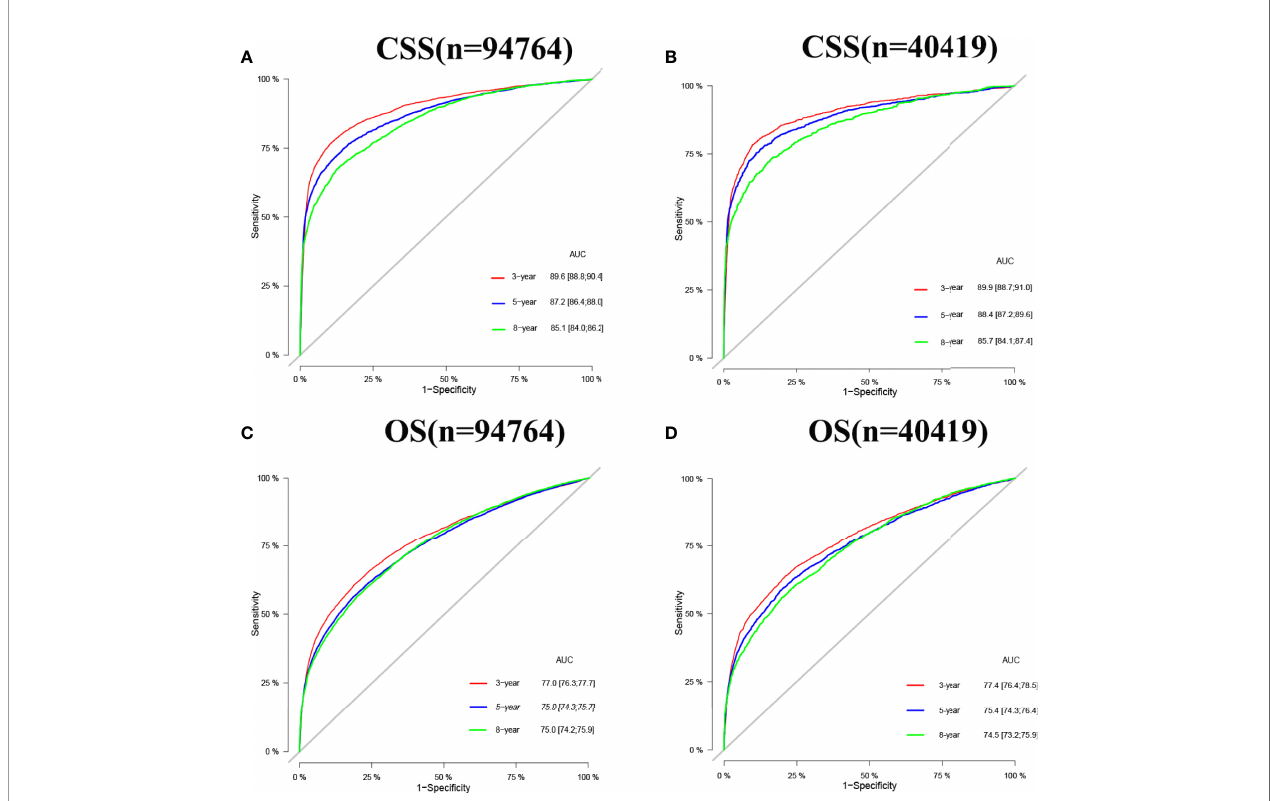
FIGURE 4 | AUC for predicting 3-, 5-, and 8-year CSS and OS in elderly patients with PC. (A) The AUC at 3-, 5-, and 8-year for CSS in the training set was 89.6,87.2, and 85.1. (B) The AUC for CSS in the validation set was 89.9,88.4, and 85.7. (C) The AUC at 3-, 5- and 8-year for OS in the training set was 77.0,75.0, and 75.0. (D) The AUC at 3-, 5- and 8-year for OS in the validation set was 77.4,75.4, and